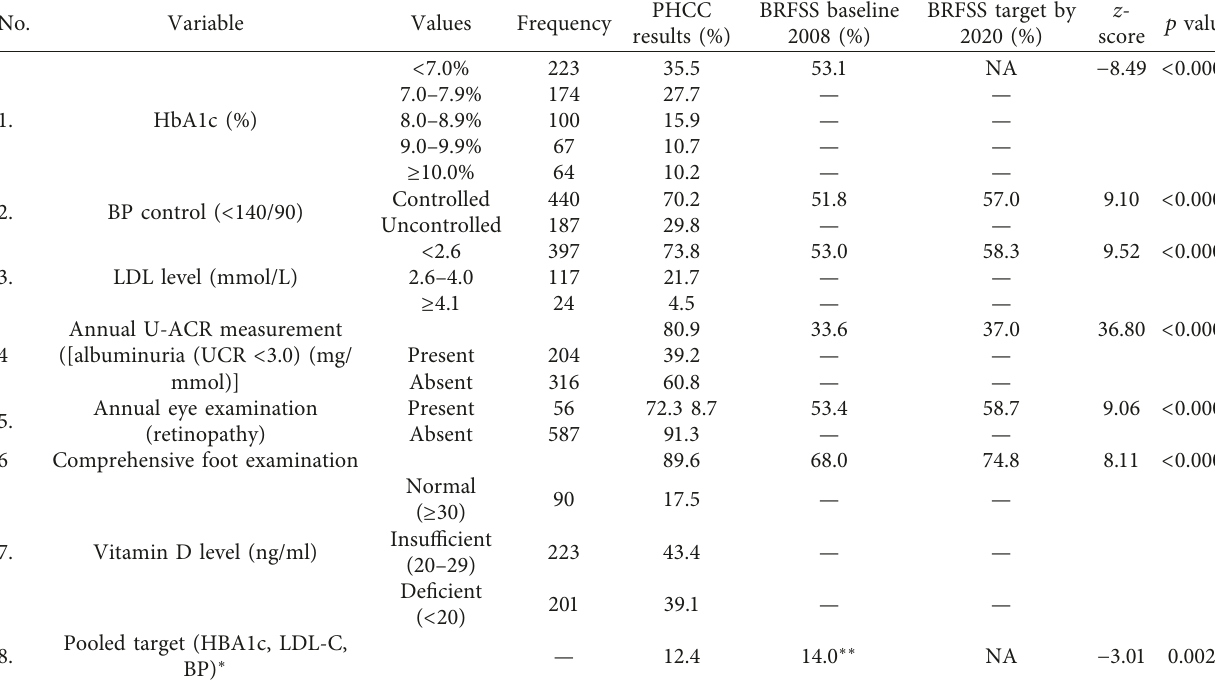
Table 3: Distribution of patients ( N � 643) by clinical outcome indicators against BRFSS, CDC/NCCDPHP (2008) benchmark.